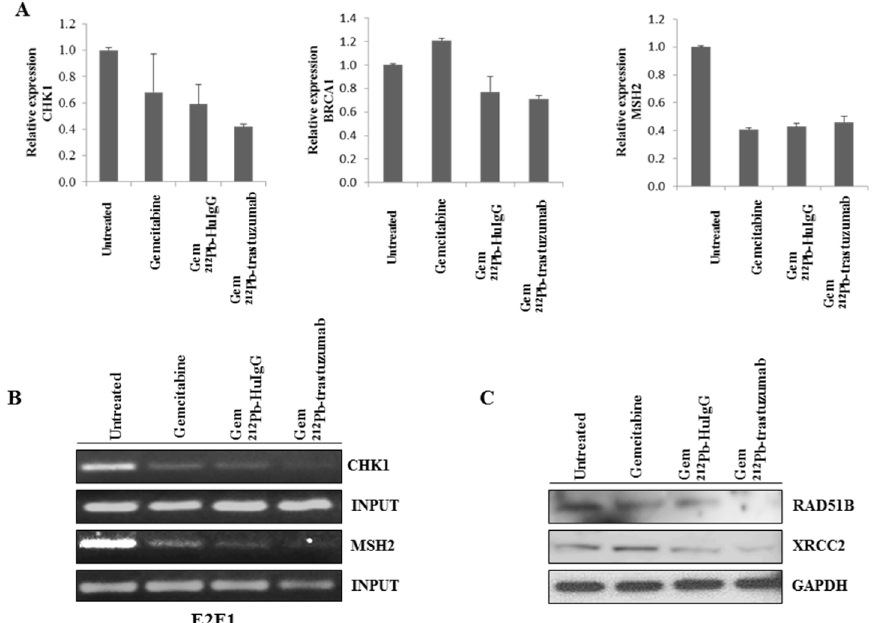
Fig 1. Expression of genes related to BASC (BRCA1-associated genome surveillance complex) and HRR in response to sequential treatment with Gem and 212 Pb-trastuzumab. Mice bearing i.p. LS-174T xenografts were pre-treated with Gem followed 24 h thereafter with 212 Pb-RIT. (A) Expression of BRCA1 , CHK1 , MSH2 and was determined by qRT-PCR. Results represent the average of a minimum of three replications. (B) Binding abundance to E2F1 was determined by ChIP using specific primers for CHK1 and MSH2 . (C) Immunoblot analysis for RAD51B and XRCC2 was performed with tumor tissue collected as described. RAD51B and XRCC2 were detected at 32 kDa and 42 kDa, respectively. Equal protein loading control was